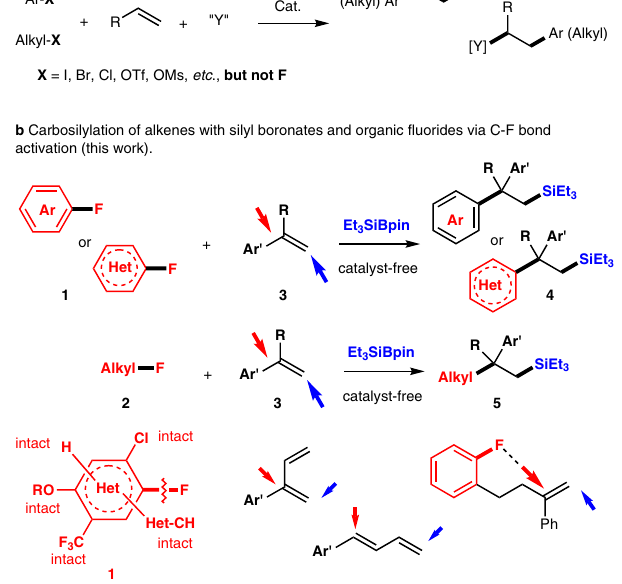
Fig. 1 Difunctionalization of alkenes. a General fi gure for the difunctionalization of alkenes. b Carbosilylation of alkenes with silyl boronates and organic fl